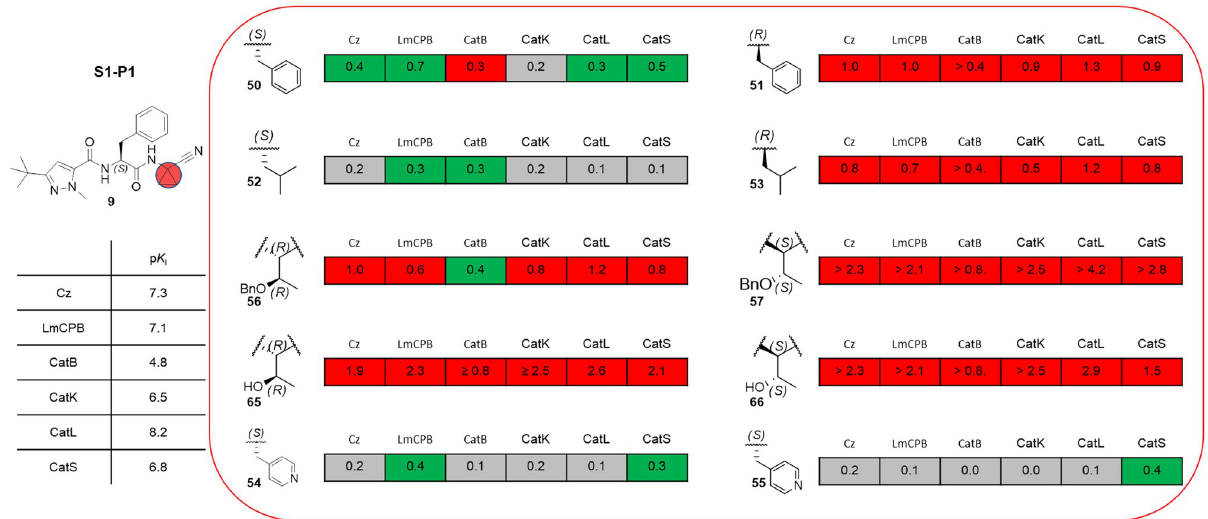
Fig 8. SAR summary for P1-S1/S1´ interactions. Values are reported as differences in p K i and are color-coded as red (negative), green (positive), grey (no significant difference, Δ p K i < 0.2).